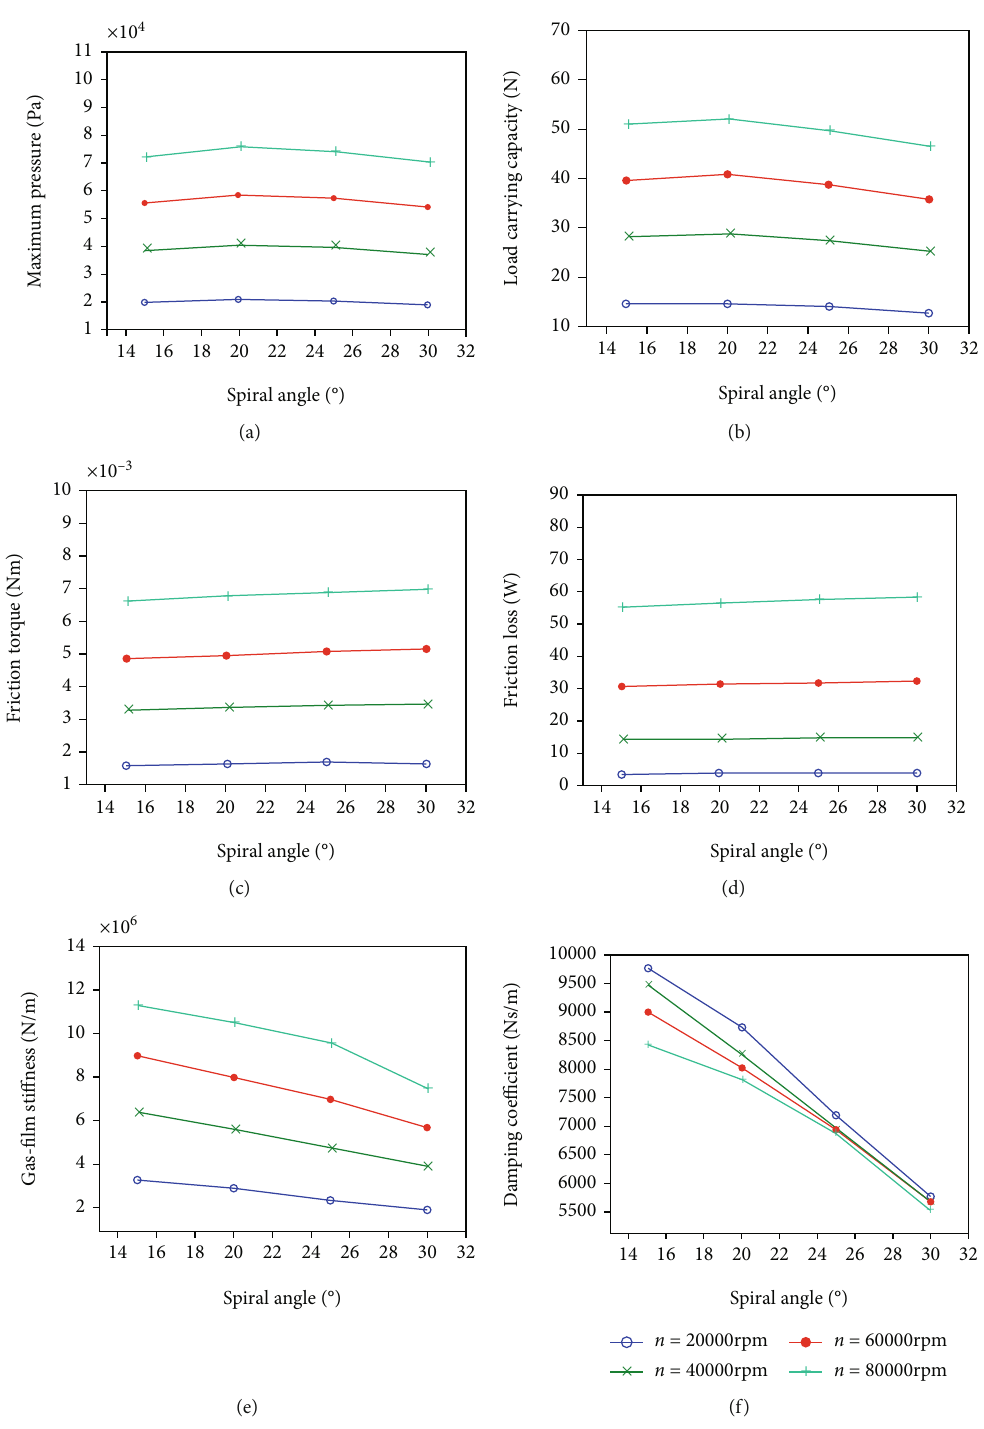
Figure 5: The lubrication performance of spiral-grooved thrust bearing with di ff erent spiral angles: (a) maximum pressure, (b) load carry capacity, (c) friction torque, (d) friction loss, (e) gas fi lm sti ff ness, and (f) damping coe ffi